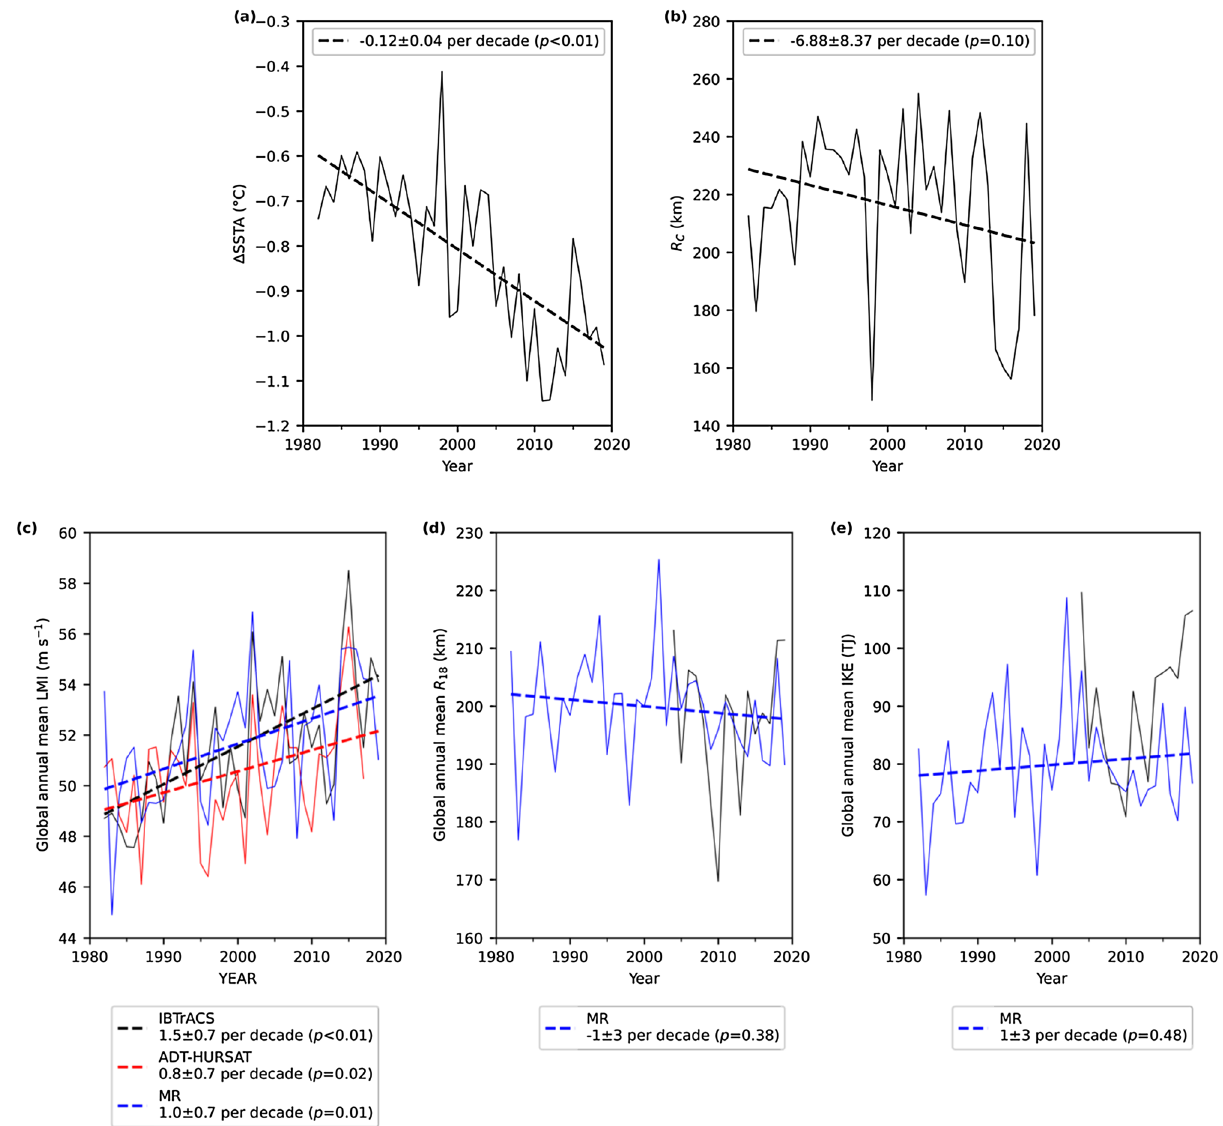
Figure 3. Annual mean time series of global TCs. ( a ) TC-induced ΔSSTA measured 3 days after the LMI passage at the location of LMI relative to the values 3 days before. ( b ) TC-induced R C measured 3 days after the LMI passage. ( c ) Observed and inferred (with multivariate regression, MR) annual mean LMI. The observed annual trends are extracted from the IBTrACS and ADT-HURSAT data sets for TCs (LMI ≥ 33 m s −1 ). ( d ) Observed and inferred R 18 at LMI. ( e ) Observed and inferred IKE at LMI. The mean ± 95% confidence interval of the linear trend (thick dash line) is given in the legend with the p